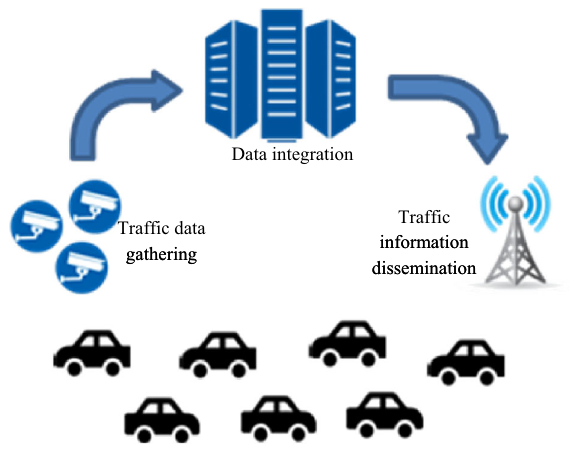
Fig. 1 Current architecture for